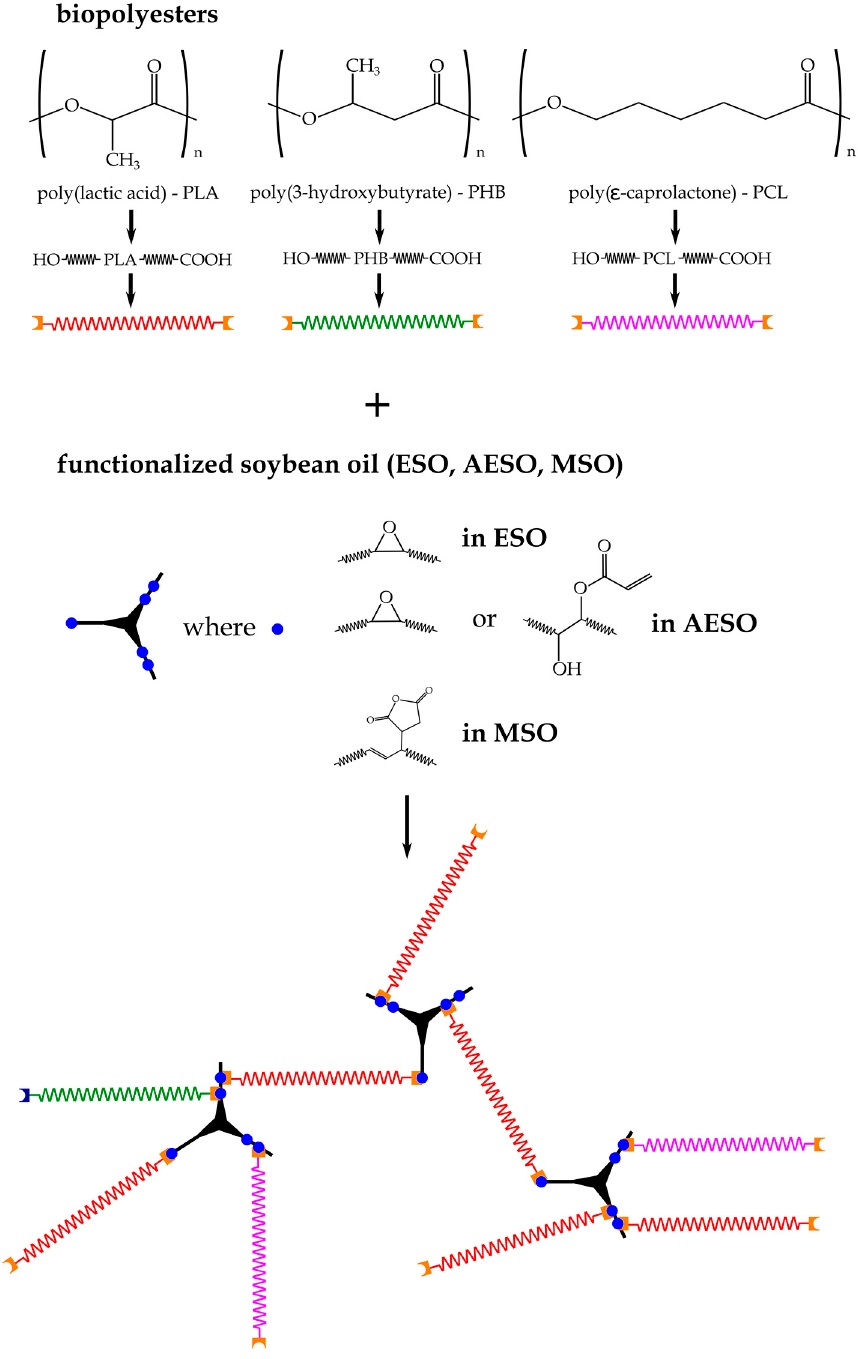
Scheme 1. Schematic representation of the possible reactions between the chemically modified soybean oil additives (epoxidized soybean oil (ESO), acrylated epoxidized soybean oil (AESO) and maleinized soybean oil (MSO)) and biopolyesters in ternary blend.